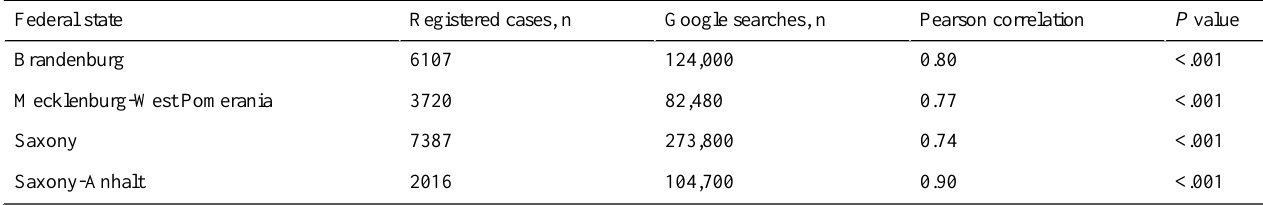
Table 1. Pearson correlation coefficients for Google searches for borreliosis and registered cases of borreliosis from January 2015 to December 2018 in Brandenburg, Mecklenburg-West Pomerania, Saxony, and